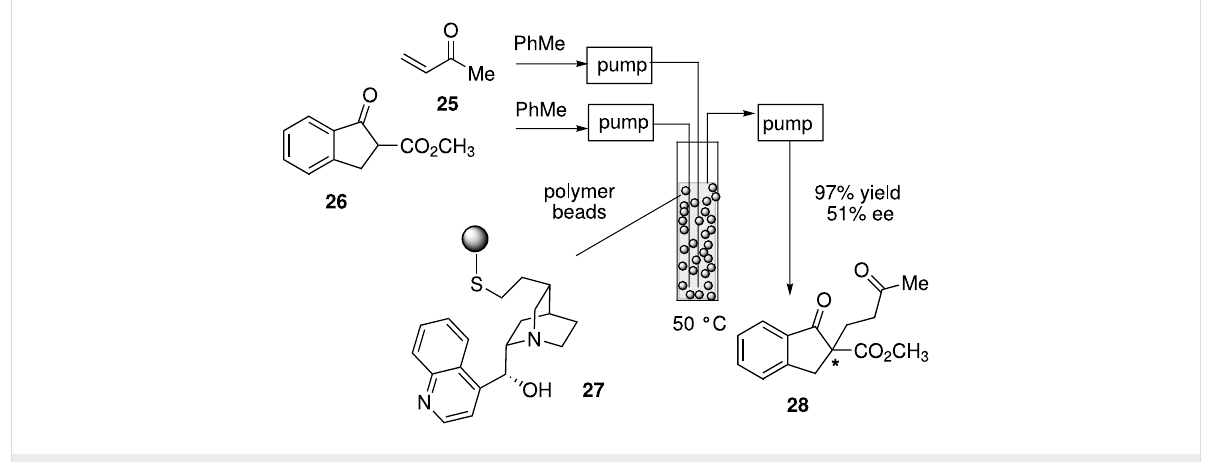
Scheme 8: Asymmetric Michael reaction in continuous